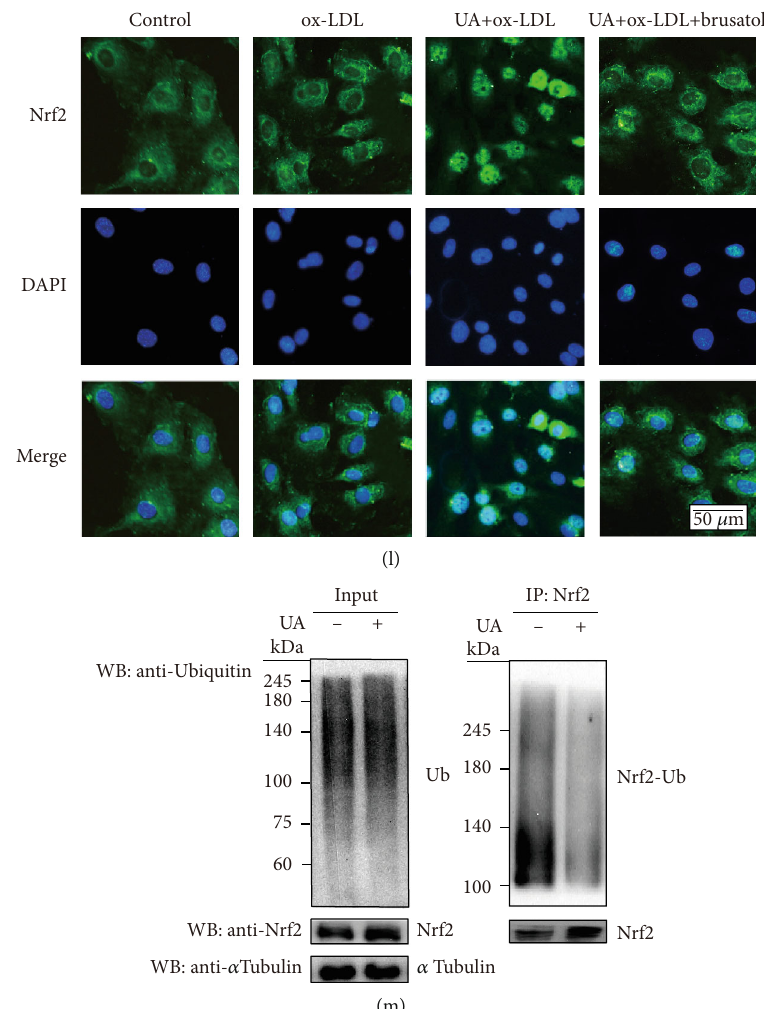
Figure 5: Nrf2 activation is associated with protective e ff ect of uric acid-mediated on ox-LDL induced HUVECs injury. HUVECs were incubated with ox-LDL (100 μ g/mL) for 24 h, with or without uric acid (5 mg/dL) preincubated for 2 h. HUVECs were preincubated with brusatol (300nM) for 2h before incubated with UA (5 mg/dL)+ox-LDL (100 μ g/mL) for 24h. (a – d) The cytosolic and nuclear compartments of HUVEC cells were fractionated, cell lysates were analyzed by Western blotting with primary antibodies against Nrf2 and Keap1. Protein levels were quanti fi ed by densitometry. α -Tubulin and histone H3 were used as internal controls. (e – h) Cell lysates were analyzed by Western blotting with primary antibodies against Nrf2, NQO1, and HO-1. Protein levels were quanti fi ed by densitometry. α -Tubulin was used as internal controls. (i) The e ff ect of brusatol, uric acid, and ox-LDL on ET-1 expression in HUVECs. ET-1 released into the supernatant was measured by ELISA. (j) The e ff ect of brusatol, uric acid, and ox-LDL on NO production in HUVECs. (k – m) Uric acid inhibited Nrf2 ubiquitination. Cells were treated with or without uric acid (5 mg/dL) for 6 h in the presence of MG132 (25 mM). For detecting ubiquitinated Nrf2, samples were subjected to IP with anti-Nrf2, followed by IB with an anti-Ub antibody. Nrf2 ubiquitination protein levels were quanti fi ed by densitometry. (l) Representative pictures showing the subcellular distribution of Nrf2 (FITC/green) in HUVECs. Nuclei were stained with DAPI (blue). Scale bar = 50 μ m. The statistical analyses were done using GraphPad Prism V-7.0 software. Data are expressed as the mean ± standard deviation ( n = 3 ). One-way ANOVA was used in statistical analyses ( n = 3 /group). ∗ P < 0 : 05 , ∗∗ P < 0 : 01 , ∗∗∗ P < 0 : 001 , and ∗∗∗∗ P < 0 : 0001 versus the control. # P < 0 : 05 , ## P < 0 : 01 , ### P < 0 : 001 , and #### P < 0 : 0001 versus the ox-LDL+UA